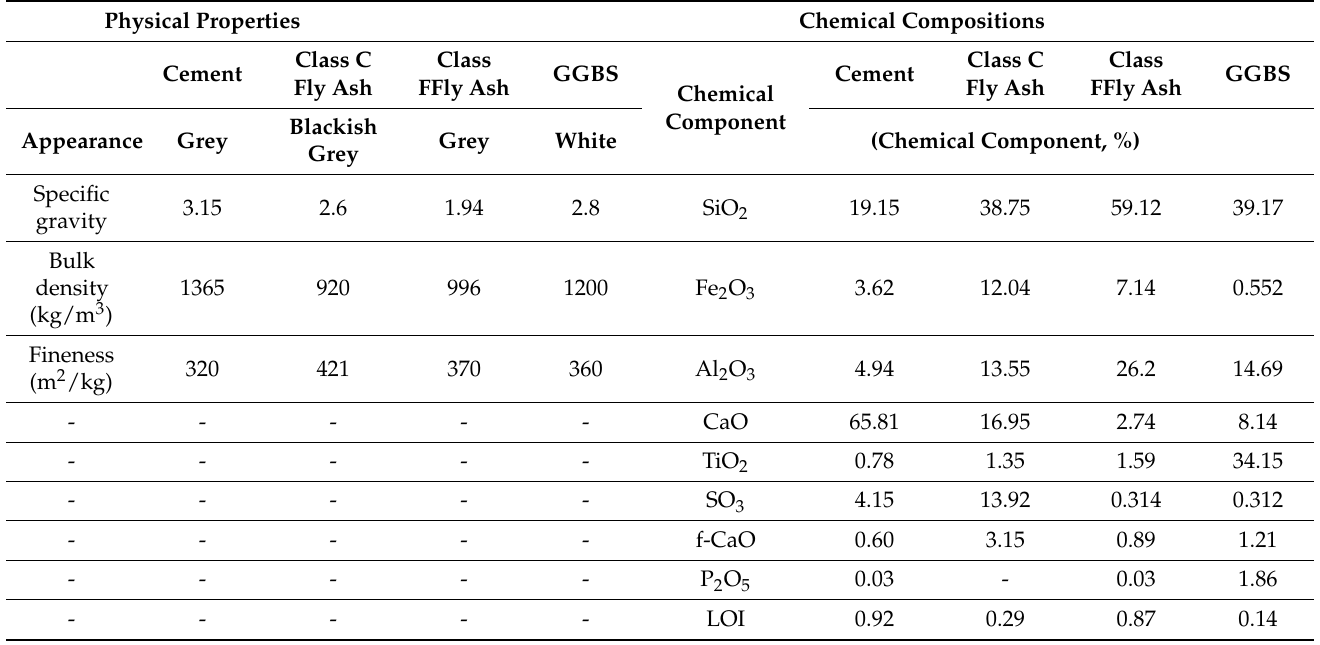
( a ) ( b ) Figure 3. ( a ) SEM image of Class F fly ash; ( b ) EDAX image of Class F fly ash. Table 1. Physical and Chemical compositions of Cement, FA, and GGBS.